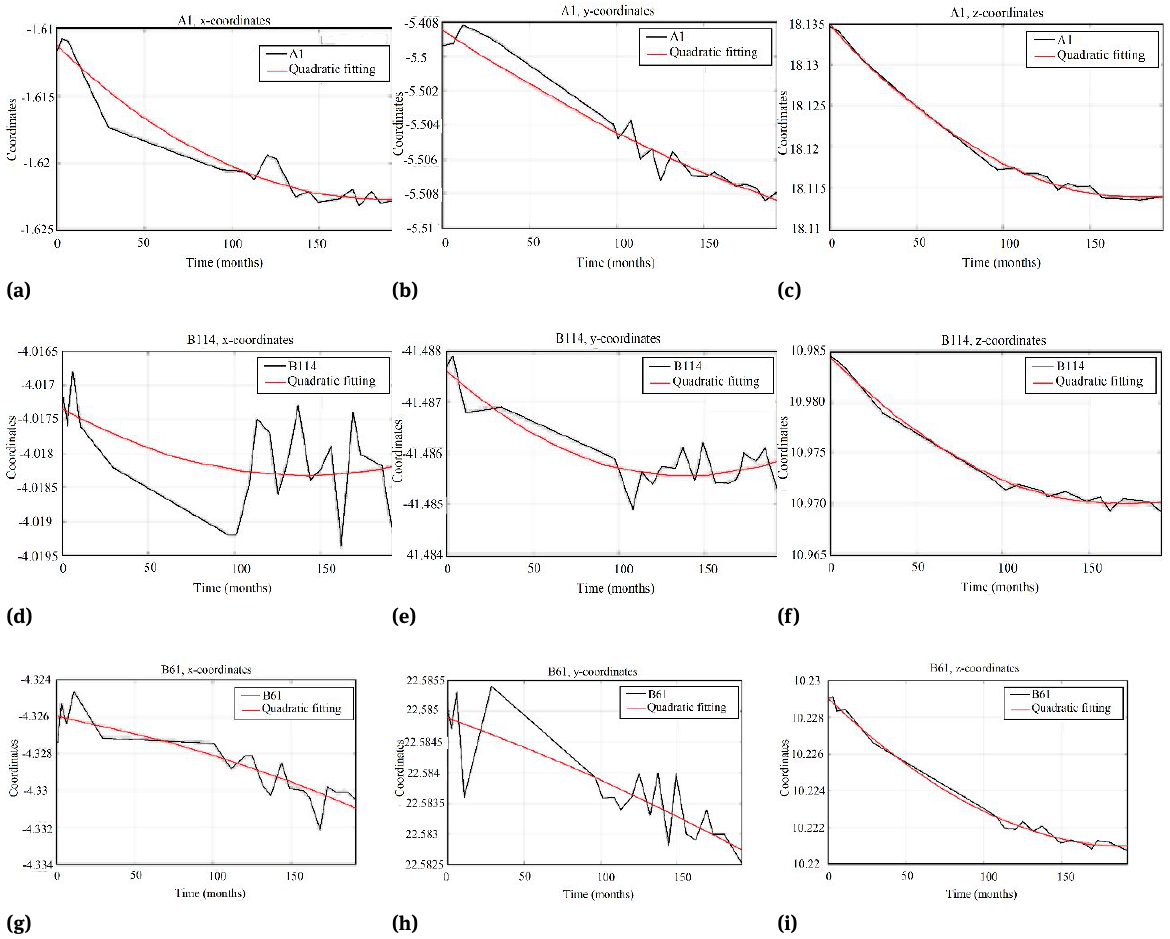
Figure 2: Time series of coordinates for points A1, B114 and